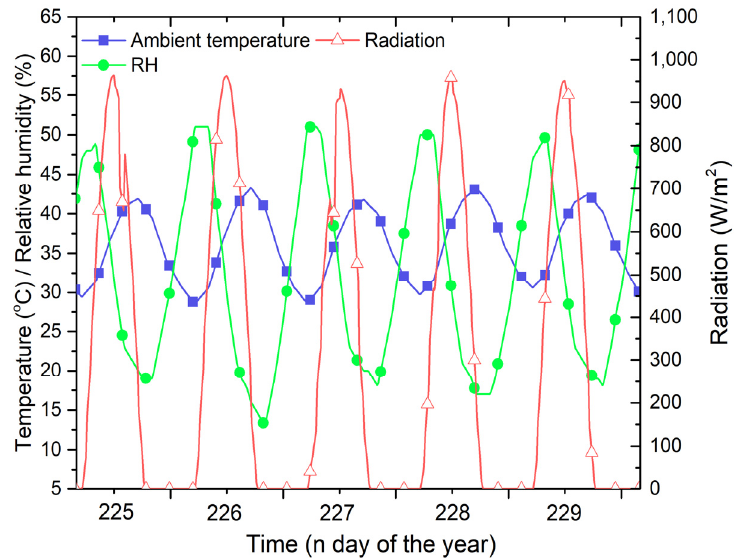
Figure 4. Ambient temperature, relative humidity, and global radiation in the simulation lapse for Puertecitos, México.